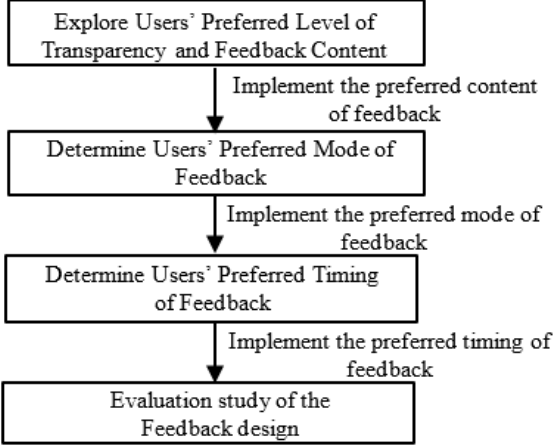
Figure 3: Experimental flow of the user